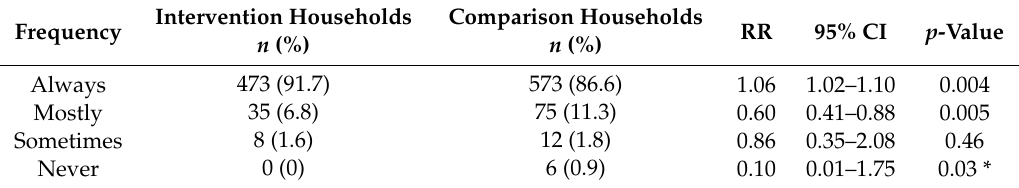
Table 3. Self-reported handwashing after toilet use.